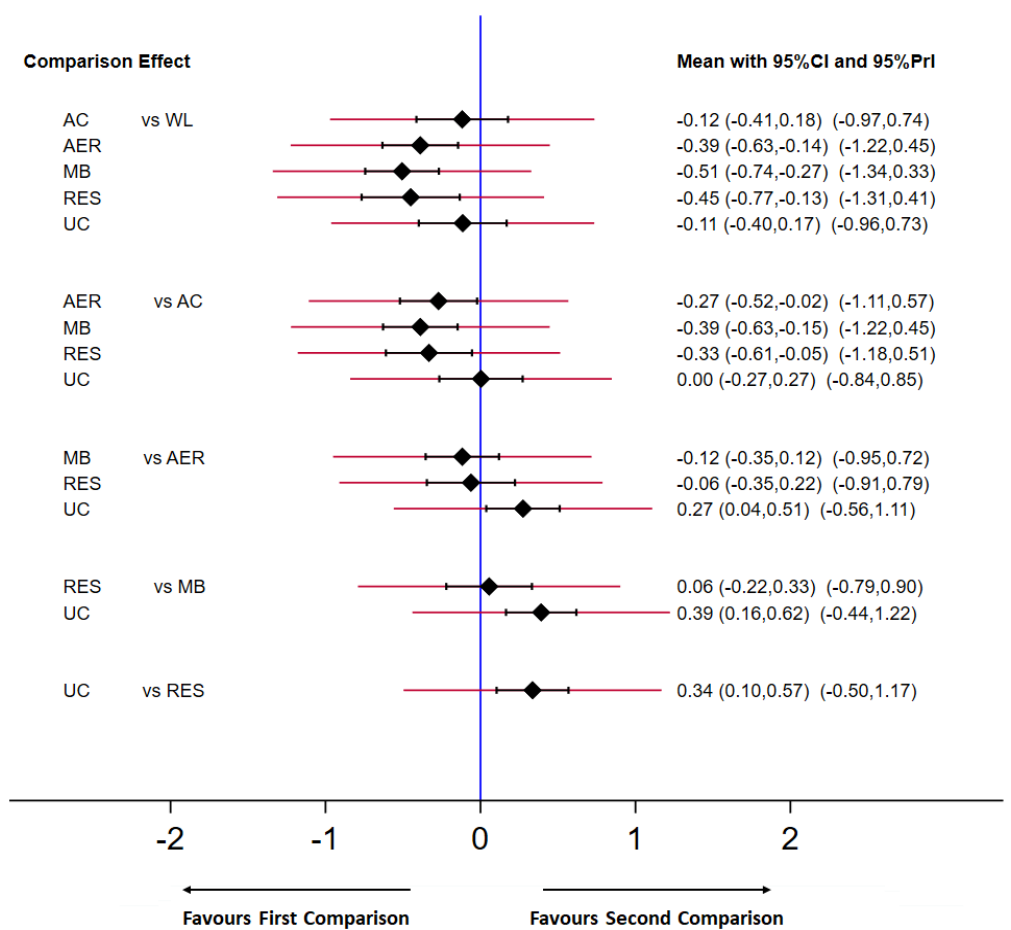
Figure 5. Predictive interval plot for the depressive symptoms network. Black diamonds represent the difference in the effect size estimate (Hedges’ g ). Narrow horizontal lines represent the confidence intervals (95% CI ) and the wider horizontal lines represent the prediction intervals (95% PrI ). The blue vertical line represents the null hypothesis (Hedges’ g = 0). Negative scores indicate a greater decrease in depressive symptoms for the comparison (left) group. AC = attention-control; AER = aerobic; MB = mind-body; RES = resistance; UC = usual care; WL =